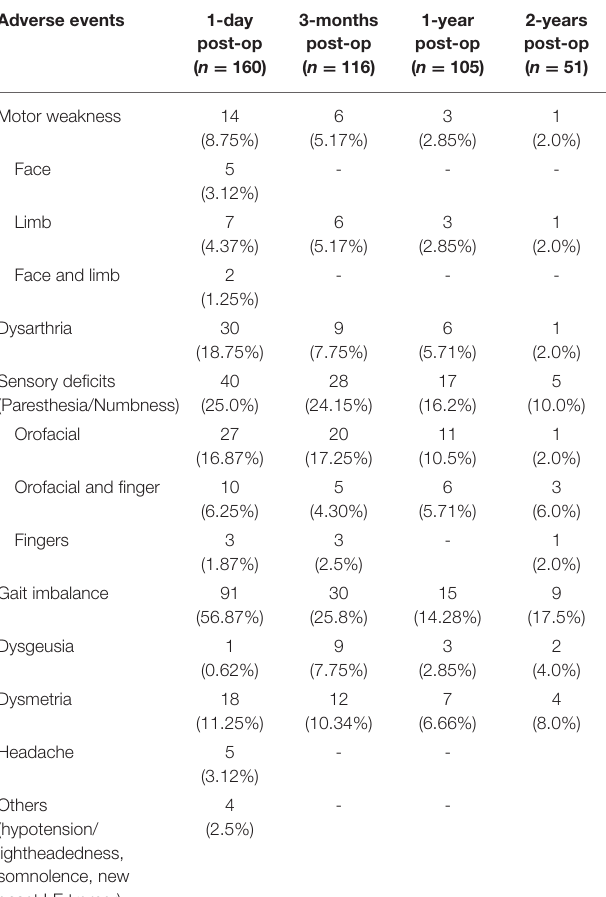
TABLE 2 | Adverse events.